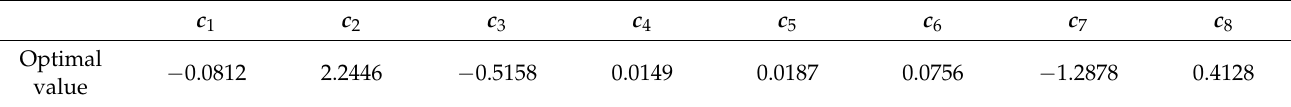
Table 2 shows the 8 optimal values of equation (8). Table 2. The optimal values of the fitting equation. Table 2. The optimal values of the fitting equation. Table 2. The optimal values of the fitting equation.